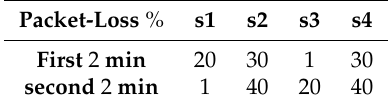
Table 8. Emulated packet-loss percentages for